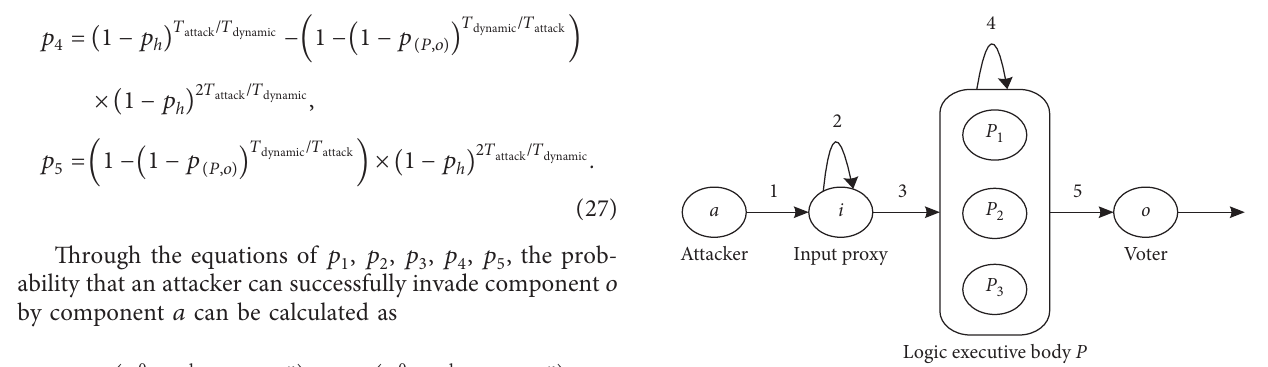
Figure 7: 3-redundancy mimic defence system security analysis